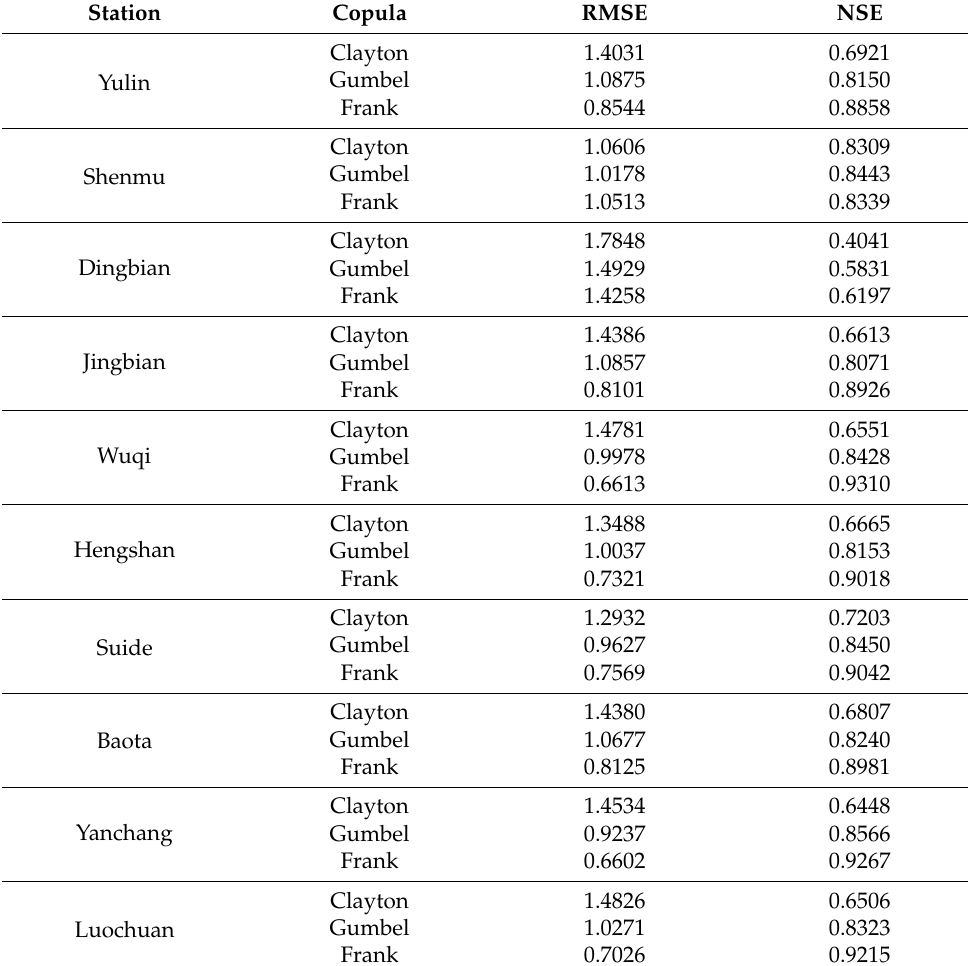
Table 5. The selection of copula